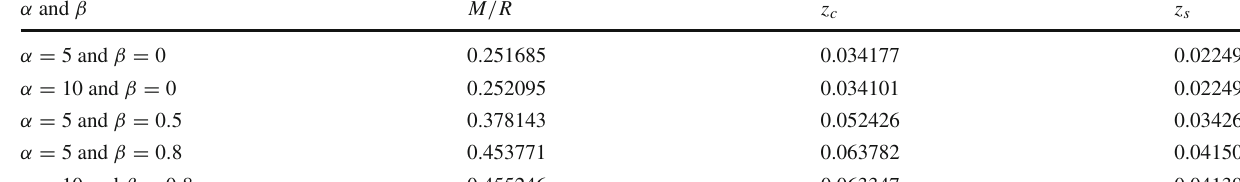
Table 2 Physical parameters of the MGD solution for 0 . 000341 km − 2 , with different coupling parameters α and β corresponding solution B